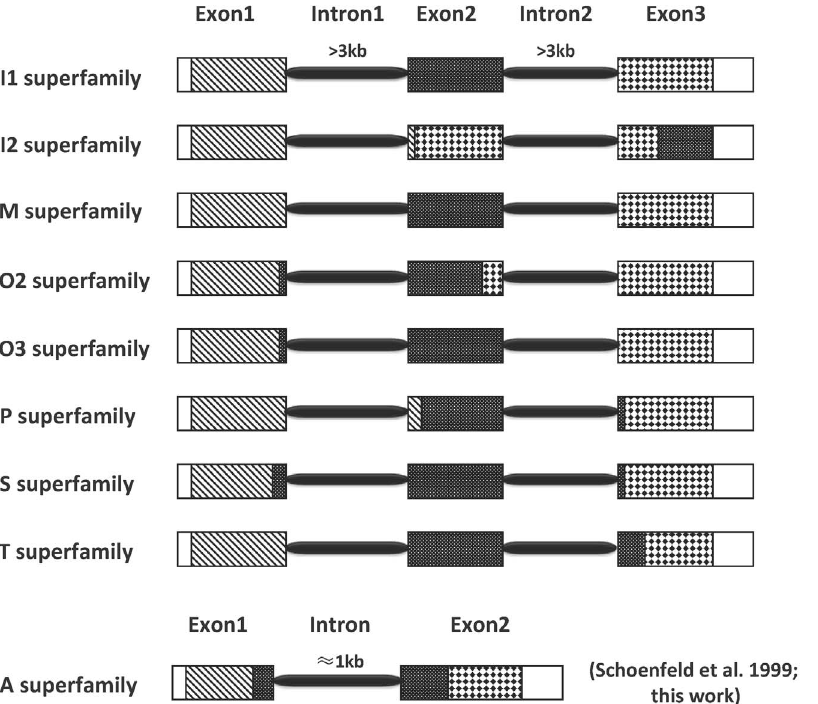
Figure 1. Gene structures of nine conotoxin superfamilies. Different segments of the toxin sequence are marked with different boxes. 5 9 or 3 9 UTR: white box; signal sequence: hatched box; propeptide and postpeptide: stippled box; mature sequence: diamond